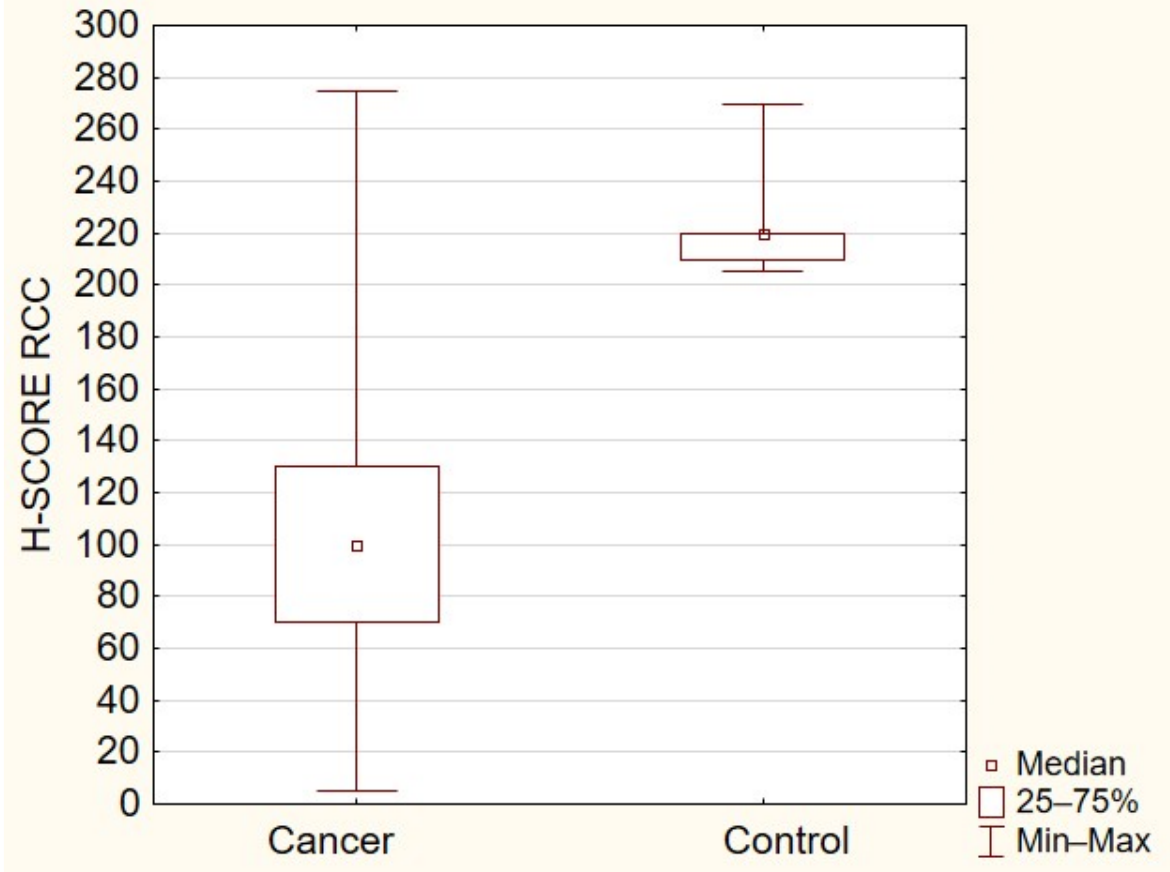
Figure 1. TOLLIP expression in RCC and control ( p < 0.05).